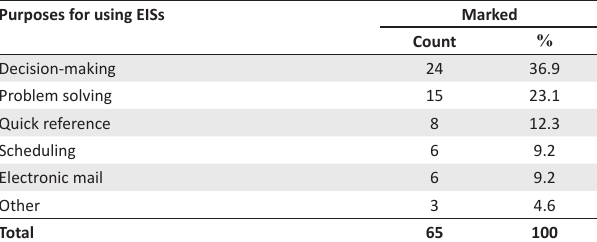
TABLE 5: Purposes for using Executive Information Systems (EISs).